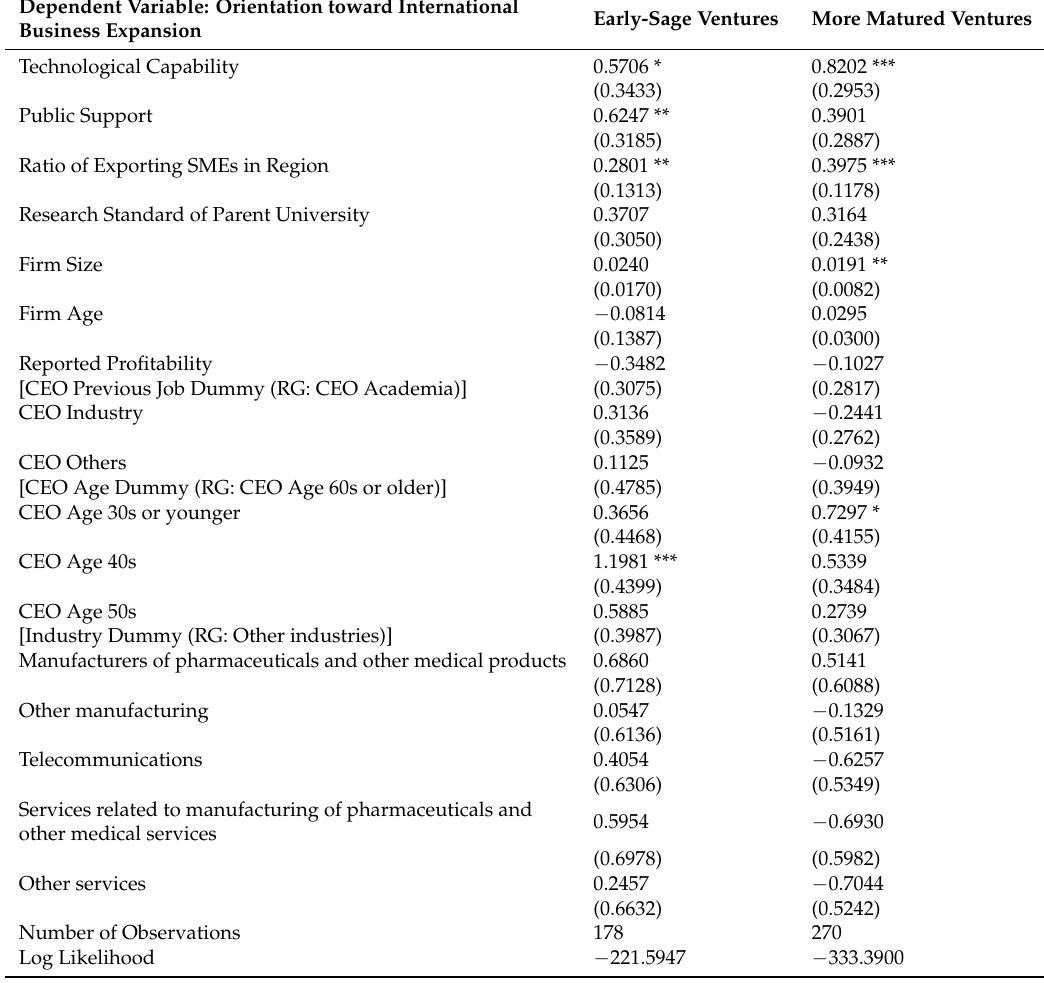
Table 6. Determinants of orientation toward international business expansion: comparison between early-stage and more matured